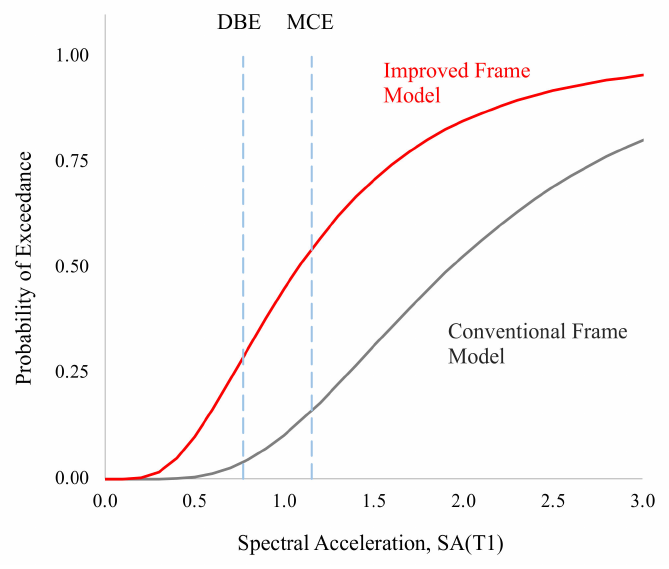
Figure 22. Collapse fragility functions for conventional and improved frame